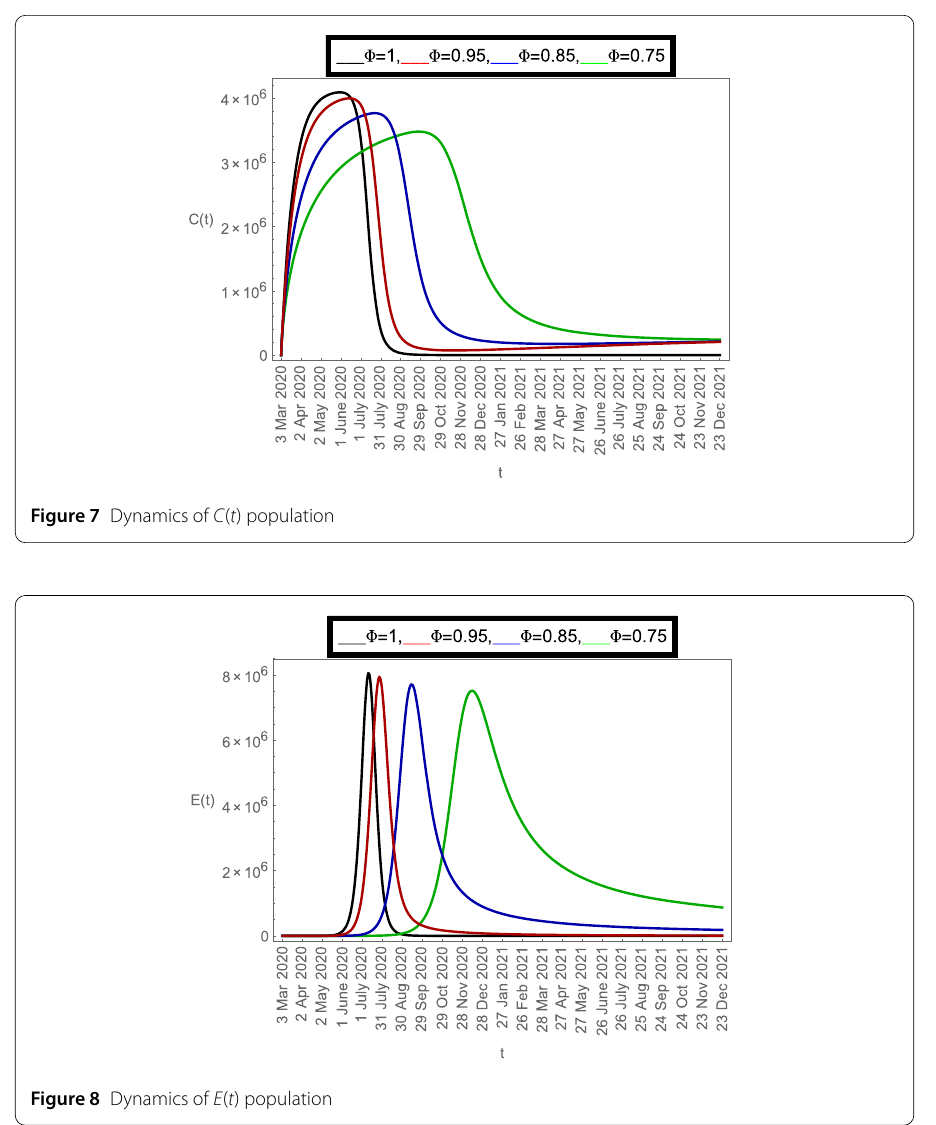
28 Dec 2020 when Φ = 0.75. This shows how the fractional-order derivatives give us more varieties to predict the real-data structure for the future. Similarly, in Fig. 9, we plotted the nature of asymptomatic individuals A ( t ) where we can see that at fractional-order Φ = 1, peak occurs at near around 31 July 2020 and when we shift to lower values of fractional order then we receive the peak near around 15 Aug 2020 at Φ = 0.95, near around 15 Oct 2020 at Φ = 0.85, and near around 27 Jan 2021 when Φ = 0.75. In this series, Fig. 10 plot- ted the nature of quarantined individuals Q ( t ) where different peaks can be seen. Here at fractional order Φ = 1, peak occurs at near around 15 July 2020 and when we shifted to lower values of fractional order then we obtain the peak around 31 July 2020 at Φ = 0.95, around 29 Sep 2020 at Φ = 0.85, and around 28 Dec 2020 at Φ = 0.75. Figure 11 described the behavior of hospitalized individuals H ( t ) for the given time range. Here at fractional order Φ = 1, a peak occurs around 15 July 2020 and when we shifted to lower values of fractional order then we receive the peak around 31 July 2020 at Φ = 0.95, around 29